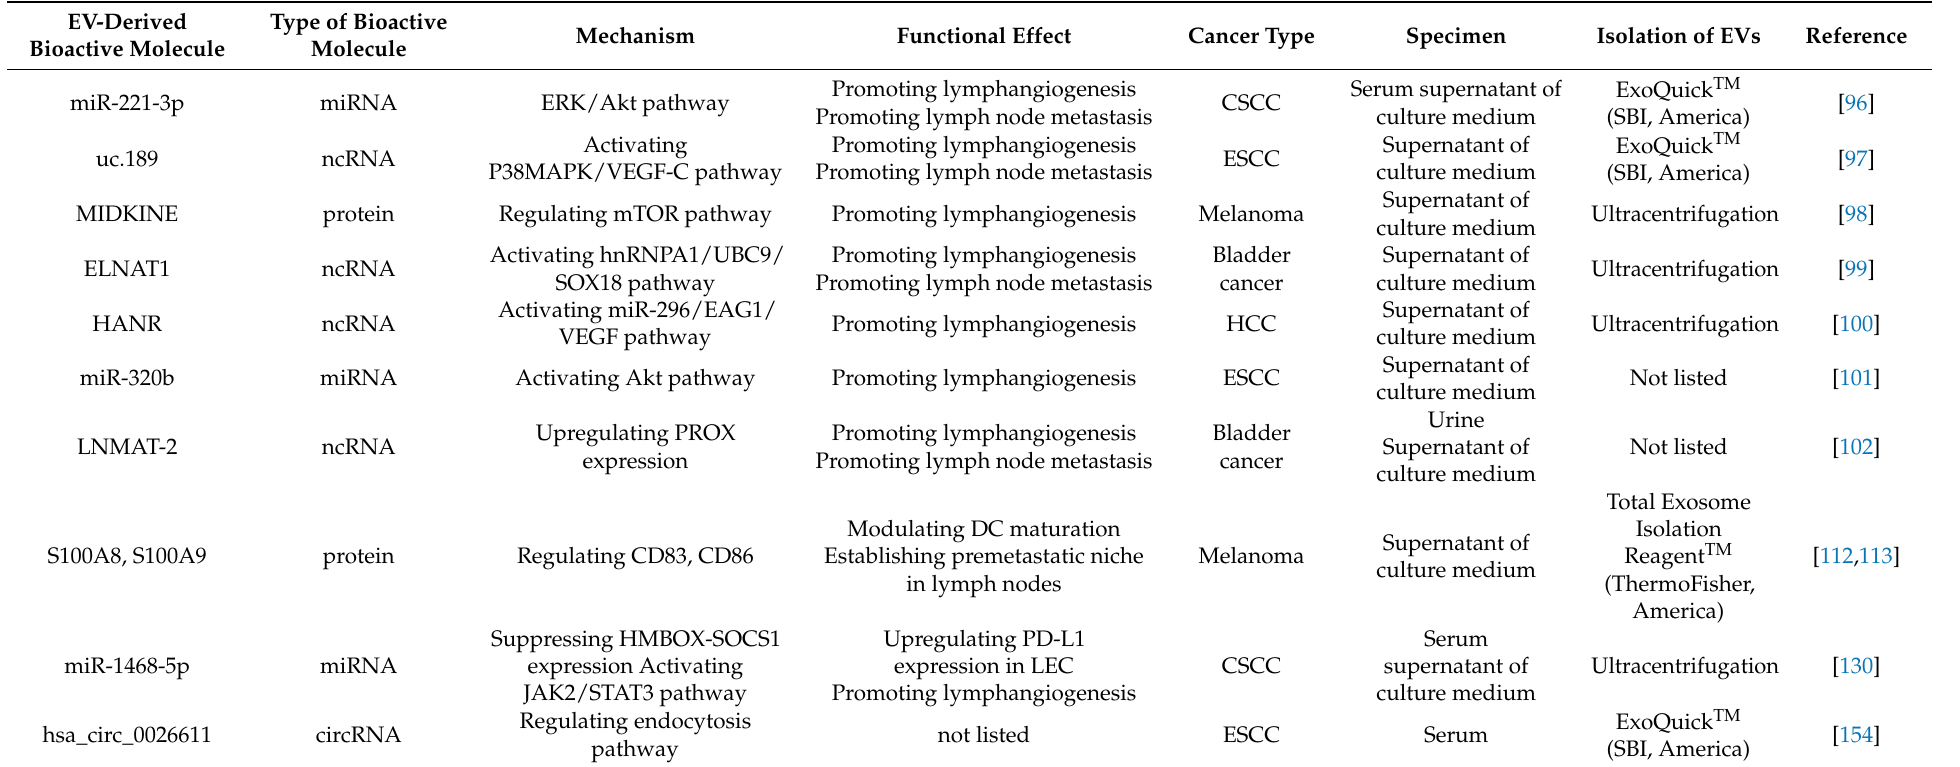
Table 1. EV-derived bioactive molecules associated with lymphangiogenesis or lymph node